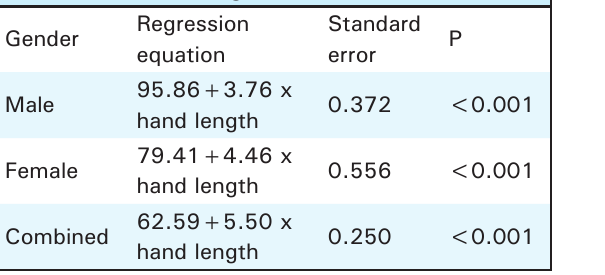
Table 2. Regression equations for the estimation of stature from hand length.